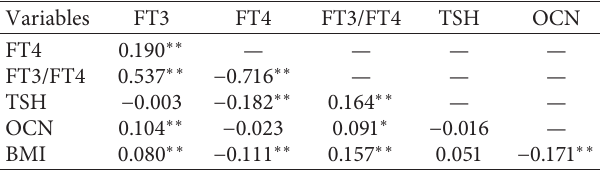
Table 2: Partial correlation analysis among serum thyroid hor- mones levels, serum osteocalcin levels, and BMI.